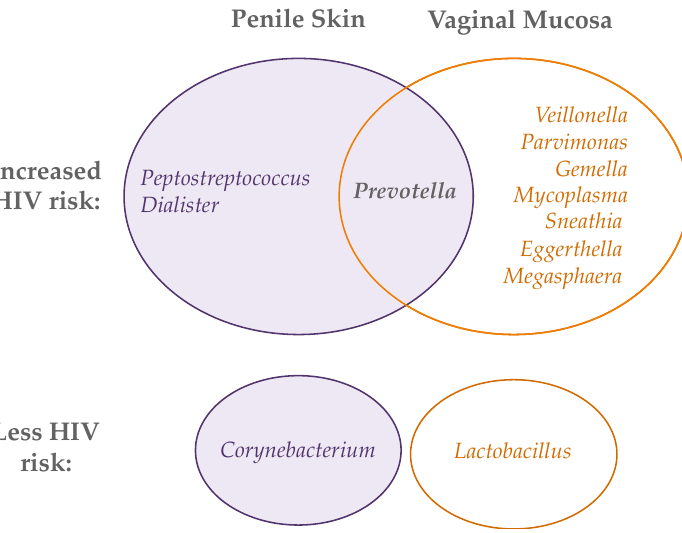
Figure 2. Bacterial genera whose abundance on the penis ( left ) and vagina ( right ) is associated with either increased ( top Venn diagram) or decreased ( bottom ) HIV acquisition.